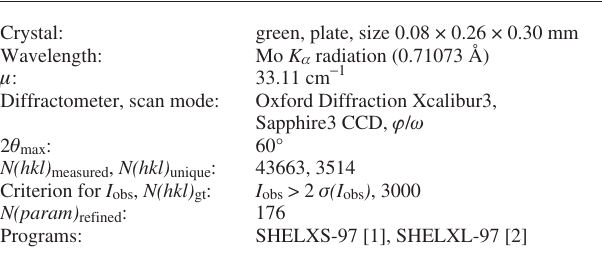
Table 1. Data collection and